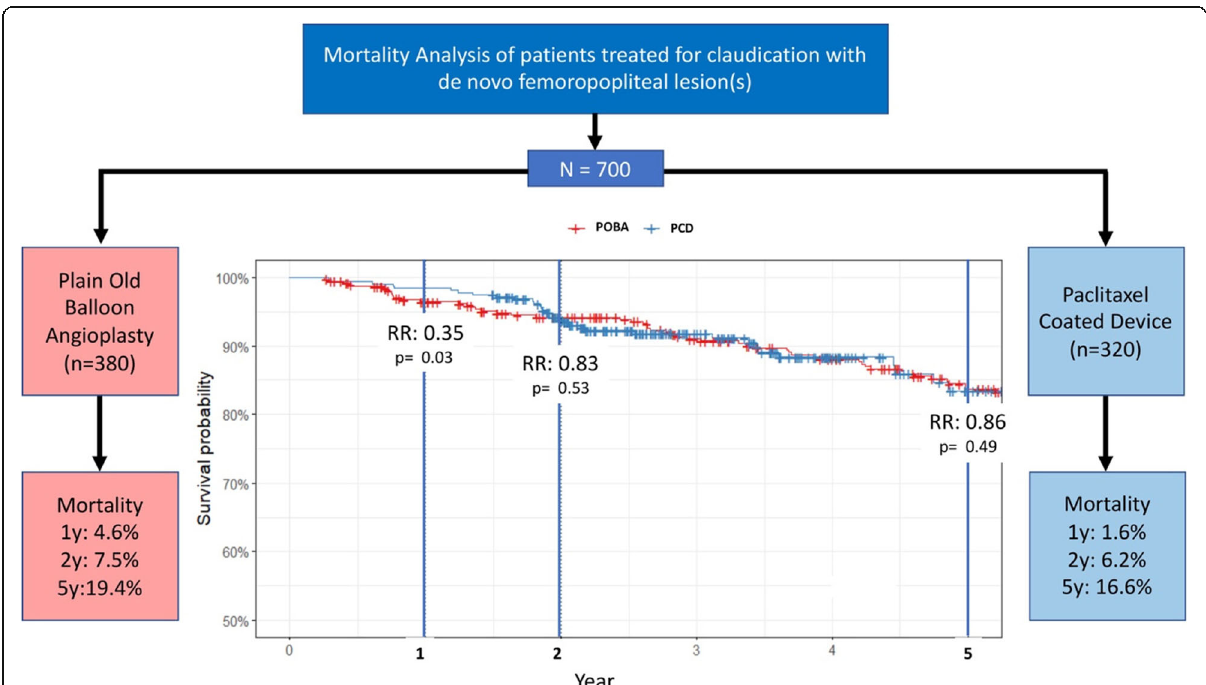
Fig. 3 Annotated Kaplan-Meier survival analysis with the relative risk-ratio (RR) at 1, 2 and 5 years of follow-up. (PCD: Paclitaxel Coated Devices; POBA: Plain Old Balloon Angioplasty)